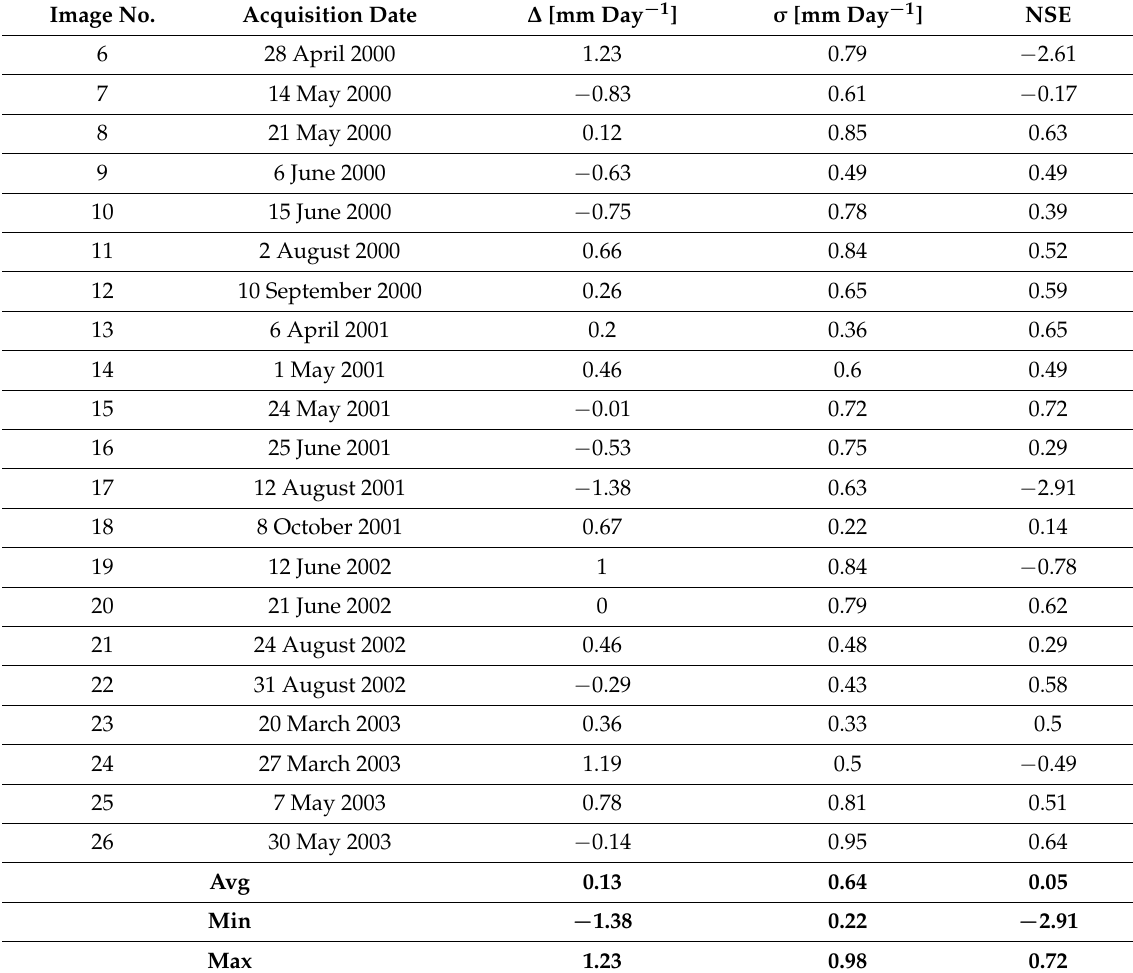
Table 4. Validation of proposed concept: raster residuals ( ∆ ), standard deviations of the residuals ( σ ) and Nash–Sutcliffe efficiency ( NSE ). Image